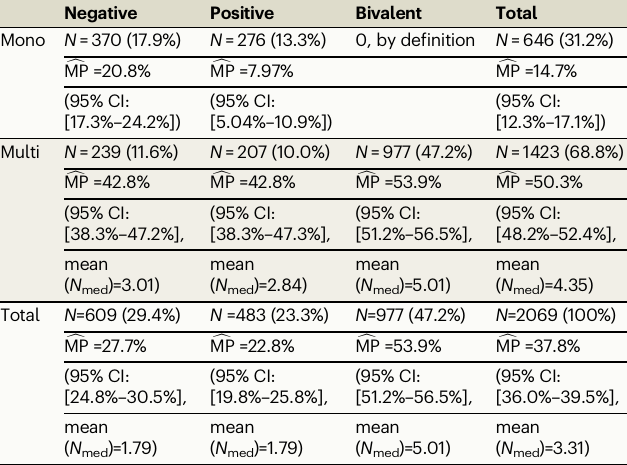
Table 1 | Exposure-to-mediator effect direction and number of mediators explaining MPs